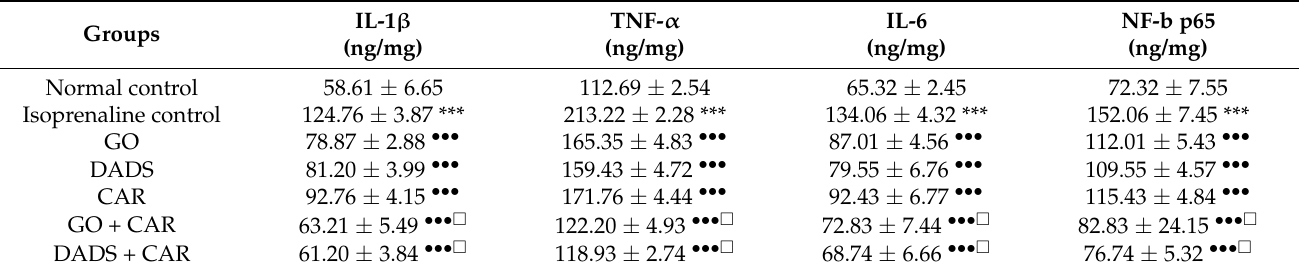
Table 4. Effect on inflammatory